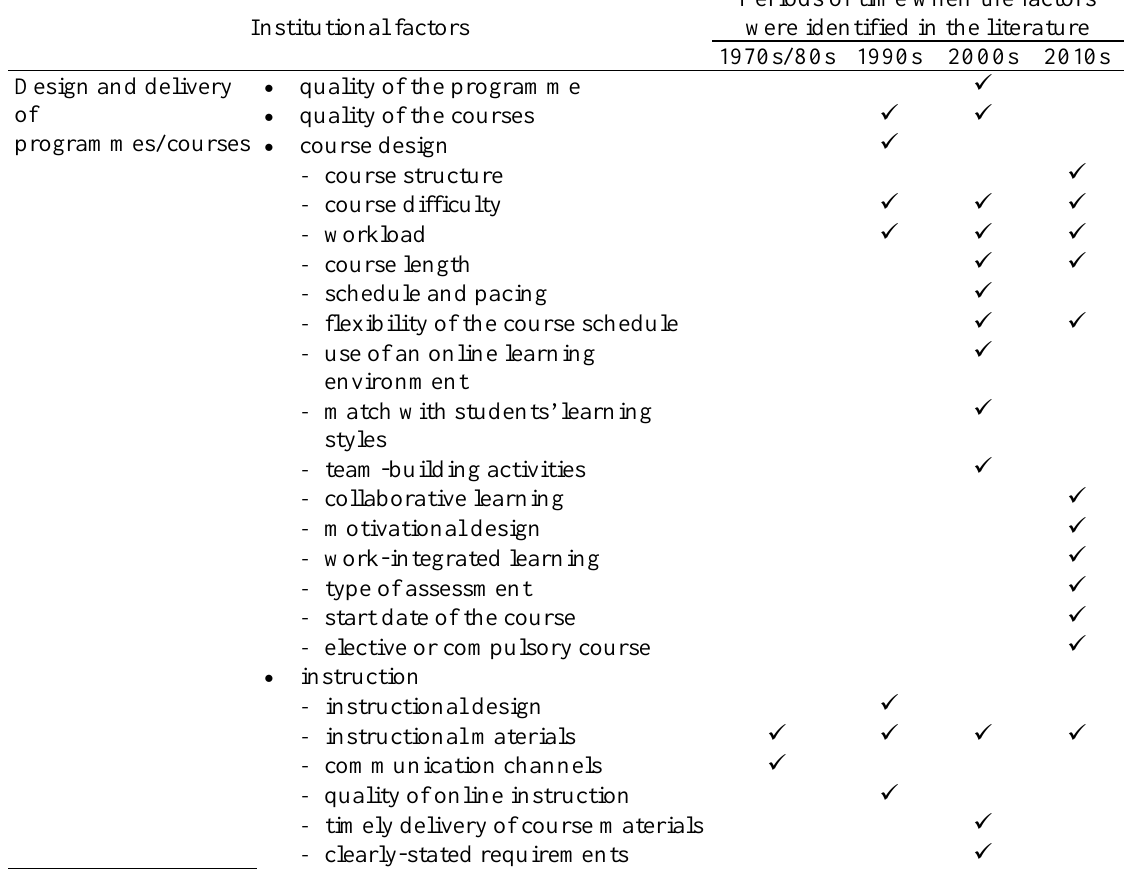
Table 4 Institutional Factors Affecting Student